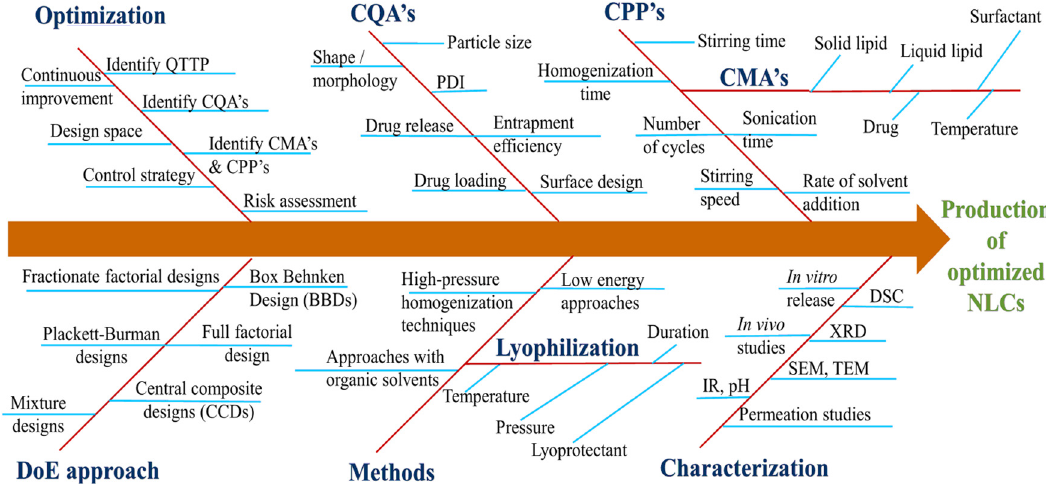
Figure 2: Ishikawa design for production of optimized